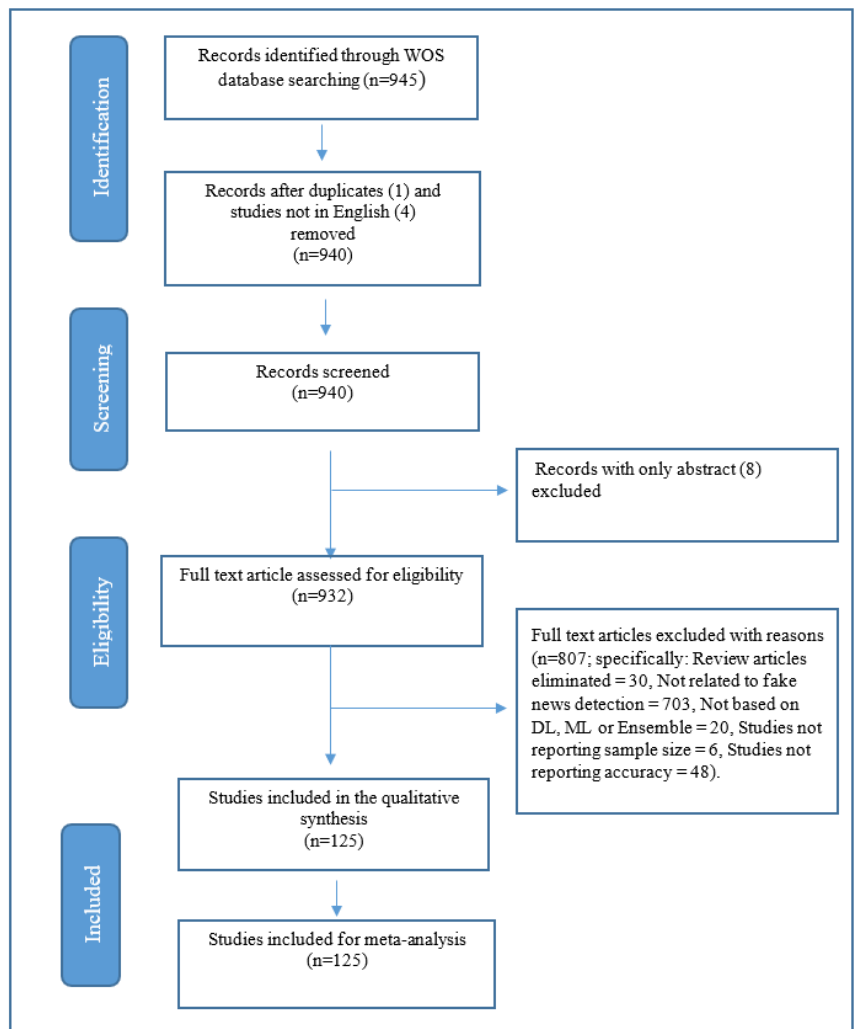
Figure 1. Flow diagram of database search using PRISMA.